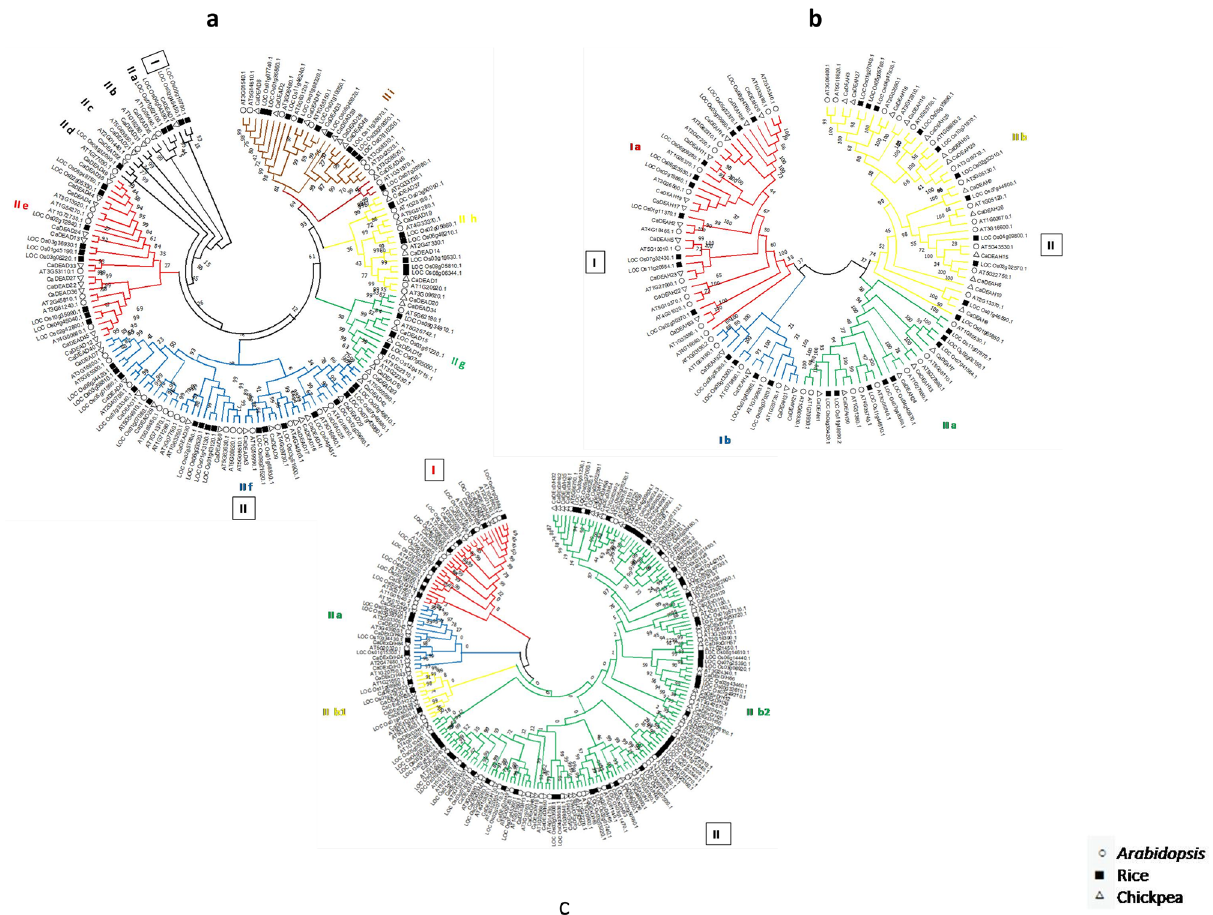
Figure 7. Phylogenetic relationships of the RNA helicases from Arabidopsis thaliana , Cicer arietinum and Oryza sativa . The trees were constructed by using the MEGA v 7 software (neighbour joining method with 1000 bootstrap replicates). Numbers at the nodes indicate bootstrap values. The coloured branches indicate the different clusters identified through the analysis. ( a ) DEAD-box helicases. ( b ) DEAH-box helicases. ( c ) DExD/H-box